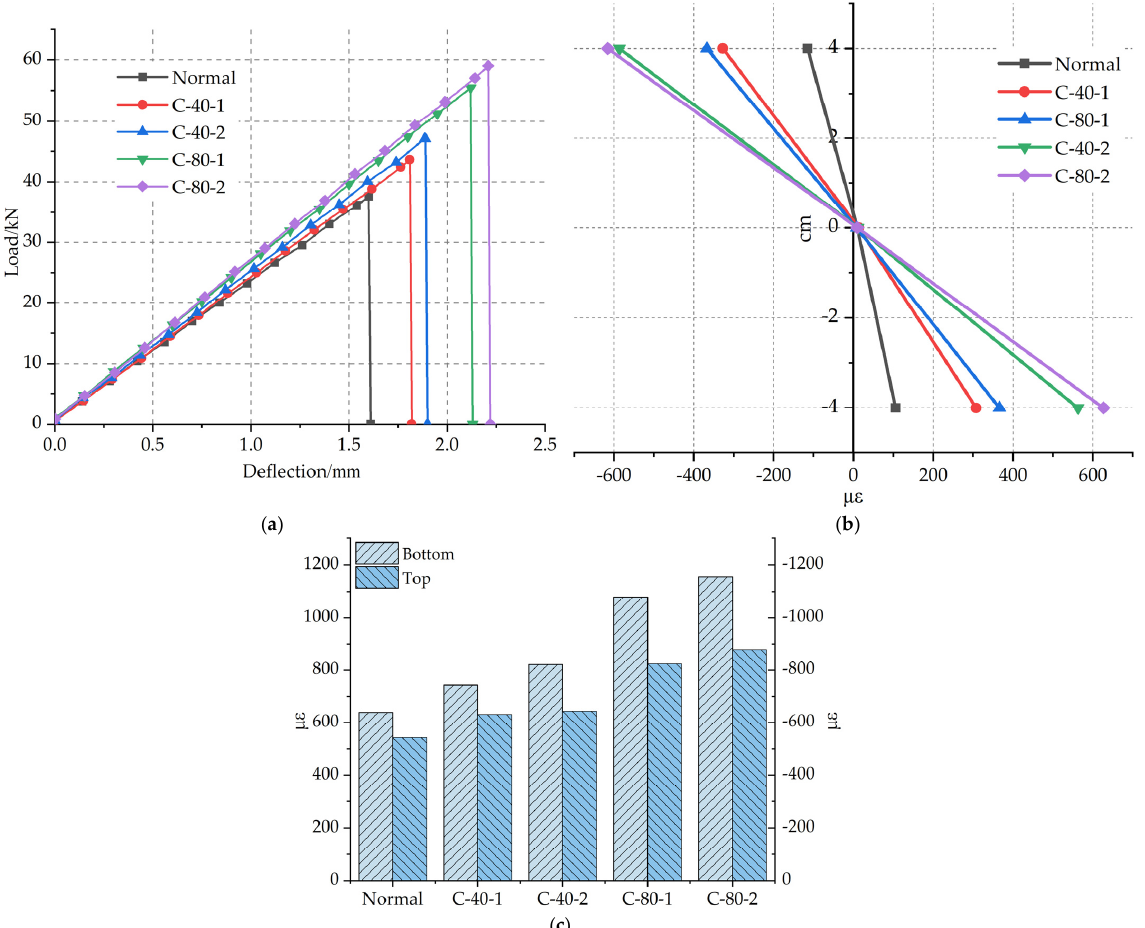
Figure 15. ( a ). Load–deflection curve for the number of different reinforced layers. ( b ). Failure strain along the beam height for the number of different reinforced layers. ( c ). Failure strain at the bottom and top of beams for the number of different reinforced layers.